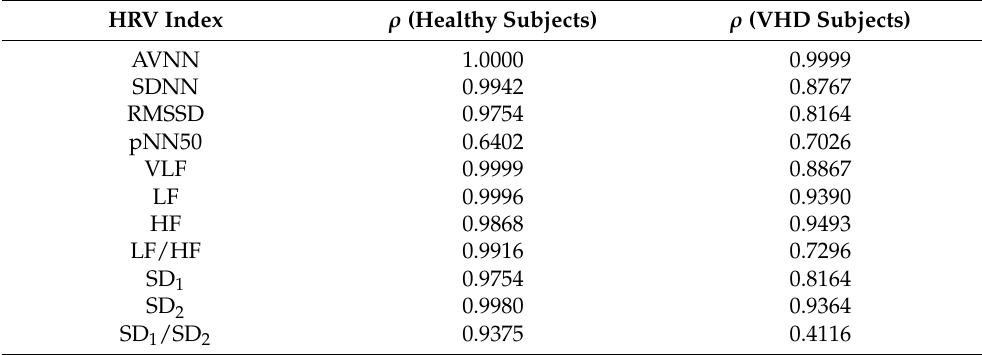
Table 6. Pearson’s linear correlation coefficient of HRV indices obtained from ECG and SCG signals.